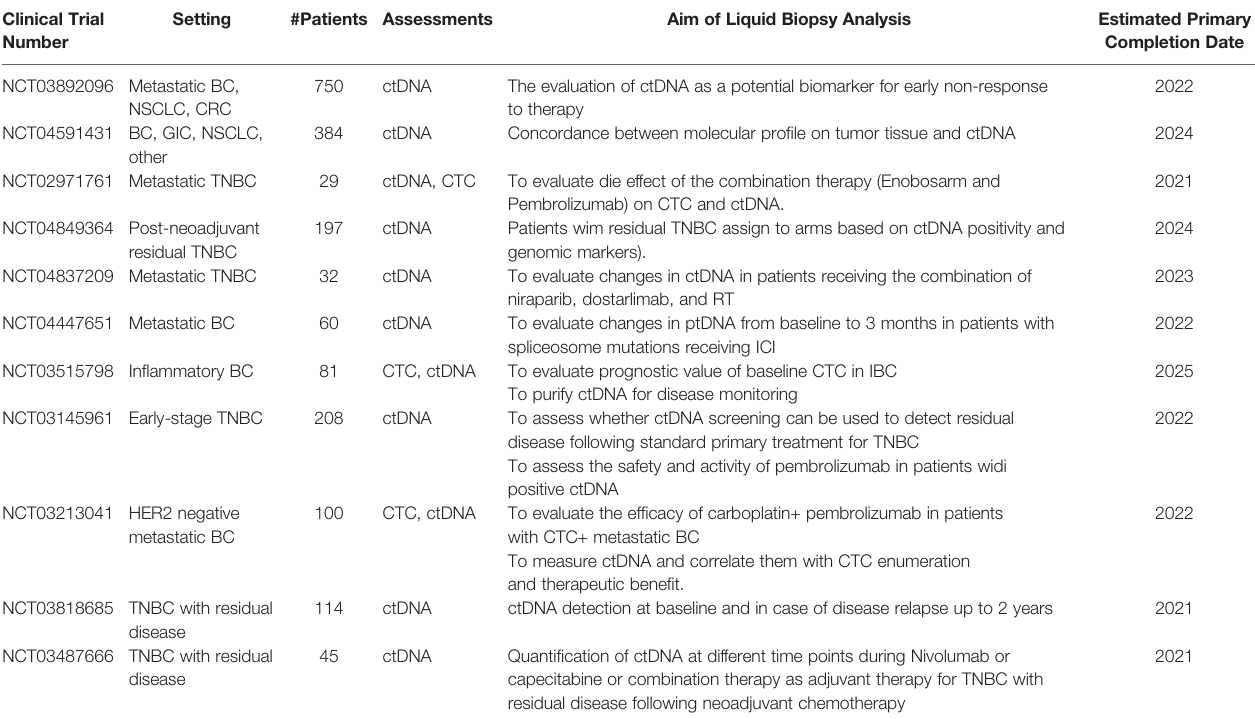
TABLE 5 | Overview of ongoing clinical trials of liquid biopsy techniques in breast cancer undergoing immunotherapy. Clinical Trial